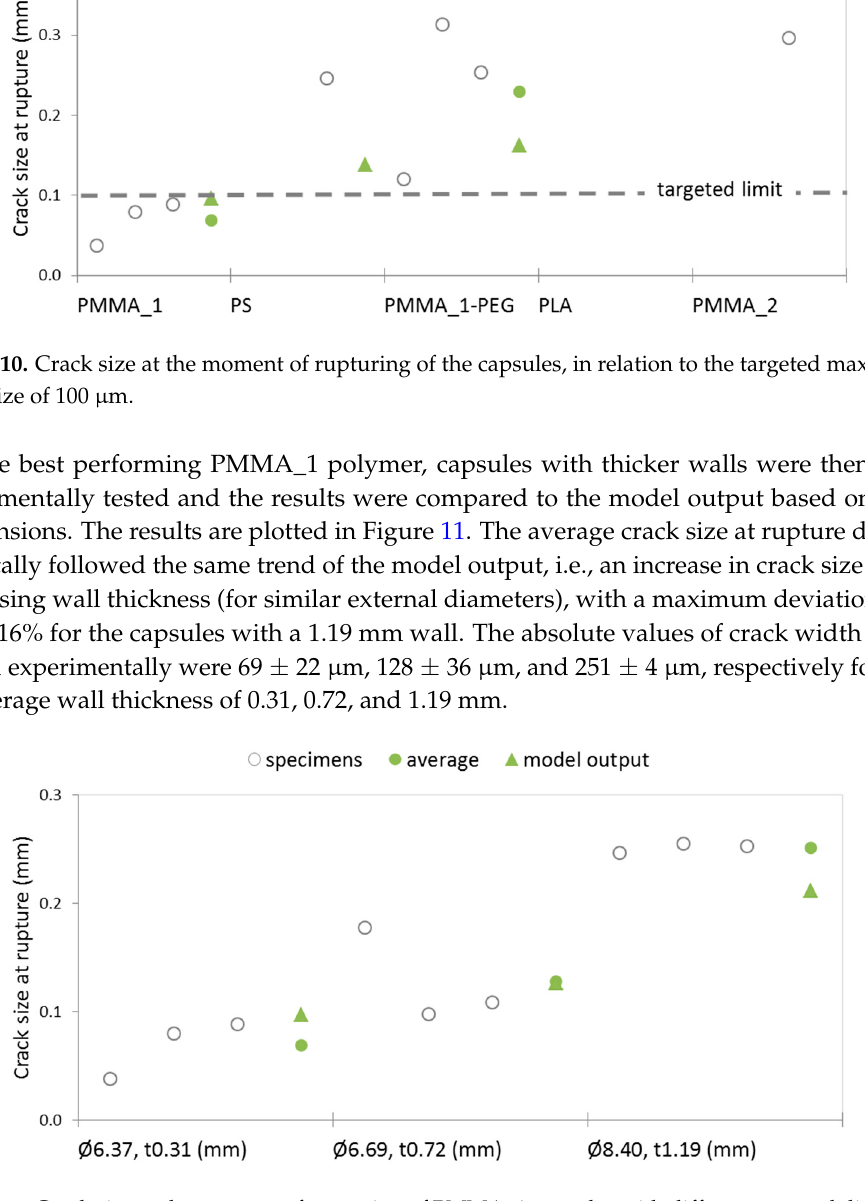
Figure 11. Crack size at the moment of rupturing of PMMA_1 capsules with different external diameter (Ø) and wall thickness (t), according to both the numerical model and the experimental results.